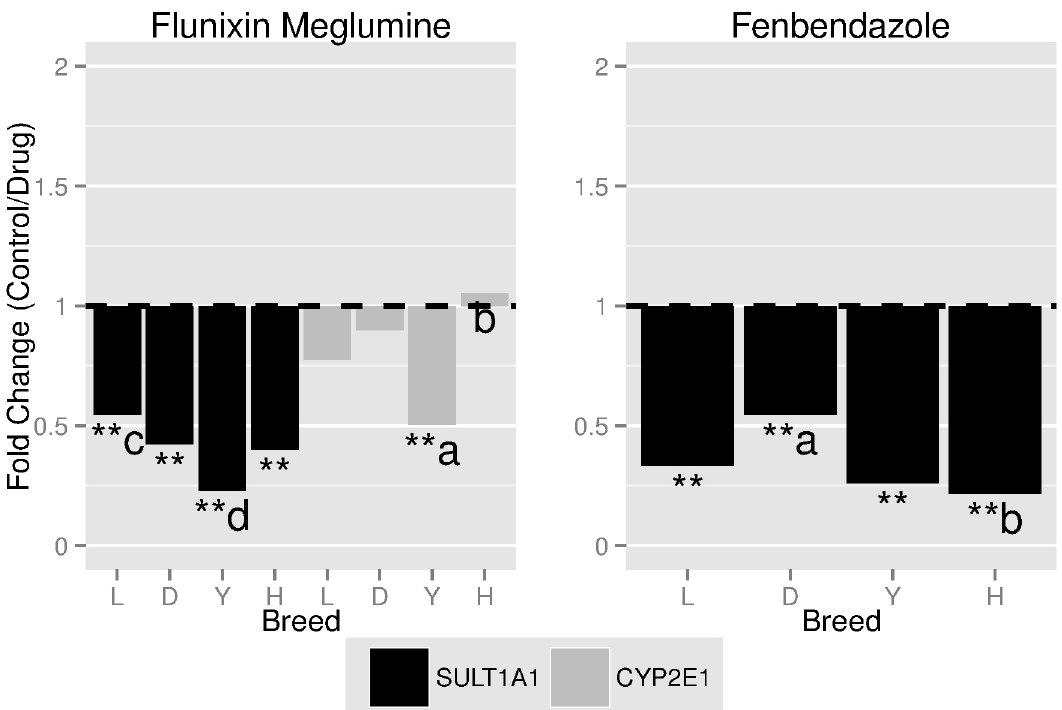
Fig 1. The fold-change 1,2 between animals given a drug and the control within each breed and sex for flunixin meglumine and fenbendazole across target genes 3 . 1 The significance threshold was set at 0.0038 (i.e. ** ) and a tendency was set at 0.0076 (i.e. * ) after the Bonferonni Correction. 2 Superscript a and b represent significant differences in fold change and c and d represent a tendency for differences in fold change. 3 Abbreviations: Cytochrome P450 2E1 ( CYP2E1 ); Sulfotransferase Family , Cytosolic , 1A , Phenol-Preferring , Member 1 ( SULT1A1